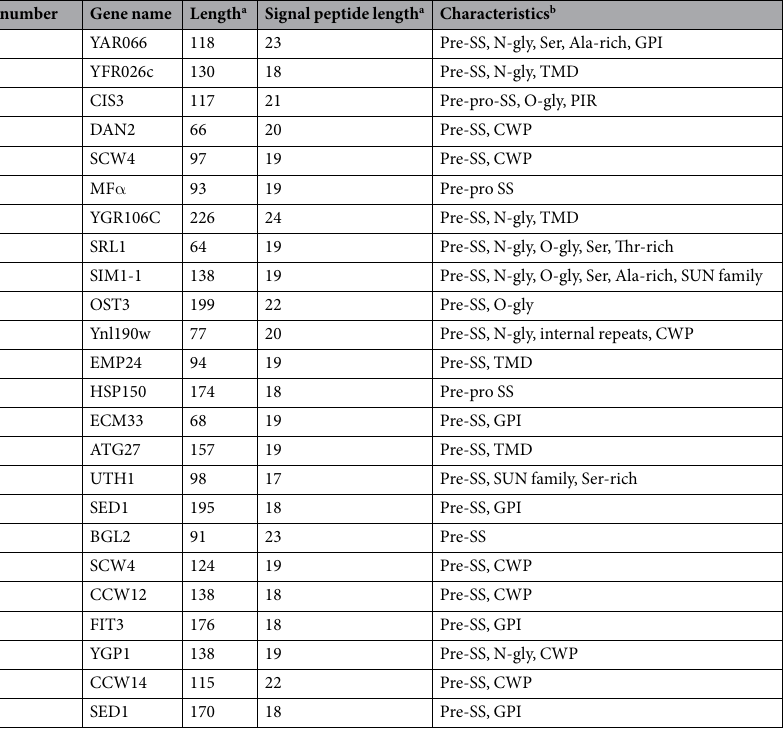
Table 2. List of translational fusion partners (TFPs) in 24 mini TFP library vectors. a Number of amino acids. b Pre-SS, pre secretion signal; Pre-pro-SS, pre-pro secretion signal; N-gly, N-glycosylation site; O-gly, o-glycosylation site; GPI, glycosyl phosphatidyl inositol anchor protein; PIR, protein internal repeats; CWP, cell wall protein; TMD, transmembrane